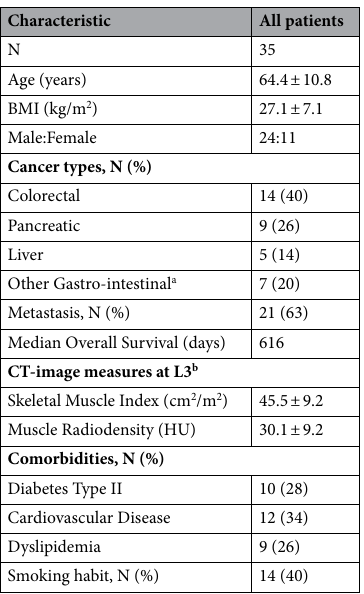
Table 1. Patient characteristics. Values are mean ± SD. a Other GI cancer includes gastric and gall bladder cancer. b CT measurements available for 33